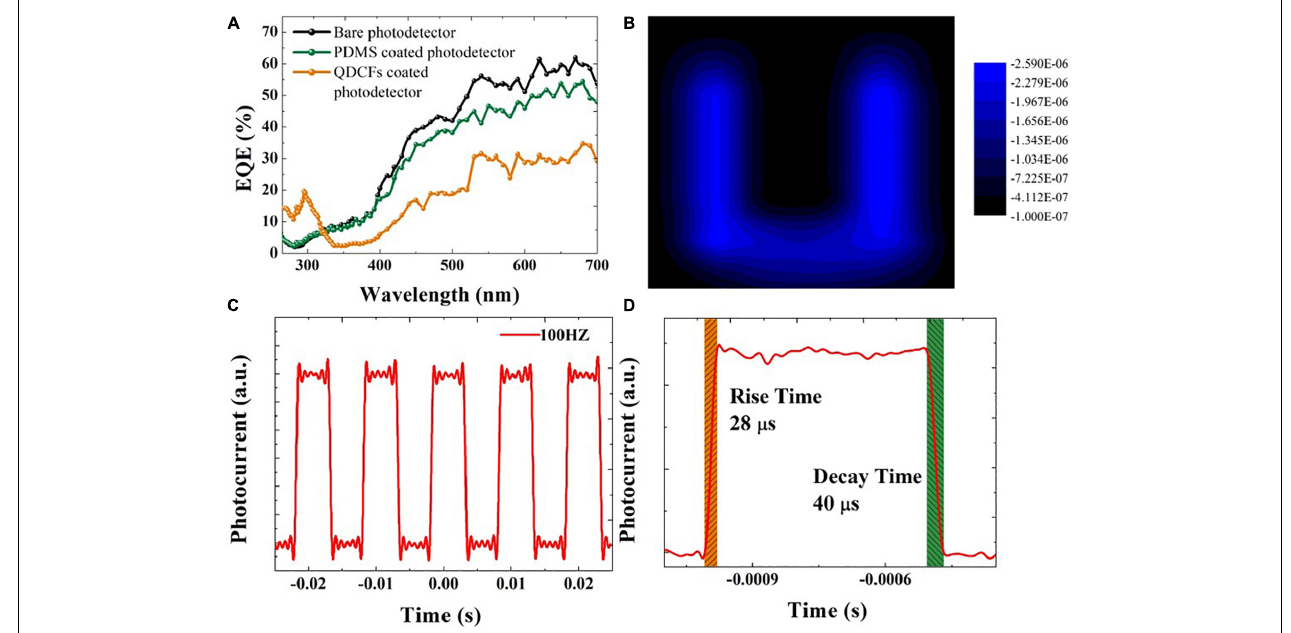
FIGURE 4 | (A) EQEs of bare, PDMS-coated, and NCCFs-coated Si photodiodes. (B) Imaging of the letter U. Photoresponse characteristics of the NCCFs-coated Si photodiodes to pulse light irradiation at frequencies of (C) 100 Hz. (D) Rising and decaying edges of one response cycle for estimating the response time of the